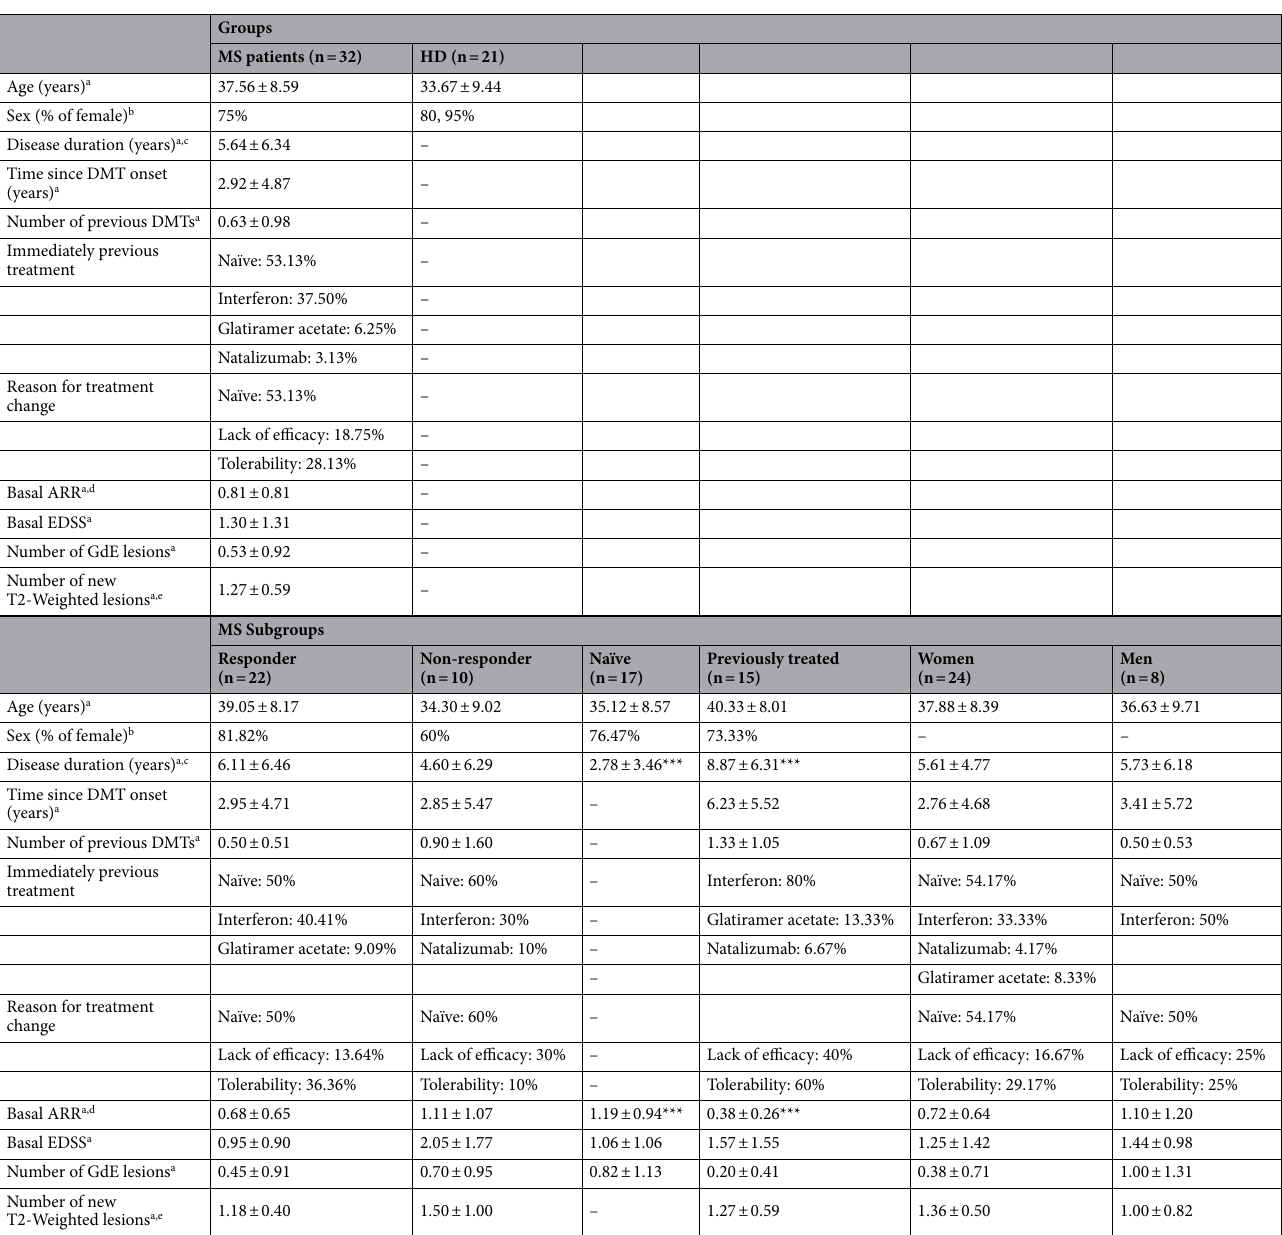
Table 1. Demographic and clinical characteristics of multiple sclersosis (MS) patients at baseline and healthy donors (HD). ***p < 0.001. a Values are the mean ± standard deviation (SD) of each group. The Mann– Whitney test was used to compare differences between MS and HD and between subgroups (Responder vs Non-responder, Naïve vs Previously treated or Women vs Men). b Chi-Square test was used to compare two proportions. c Time since the first symptoms of MS. d For Basal ARR, only the previous year was considered. e Data not available for naïve MS patients, as most of them had a single magnetic resonance imaging